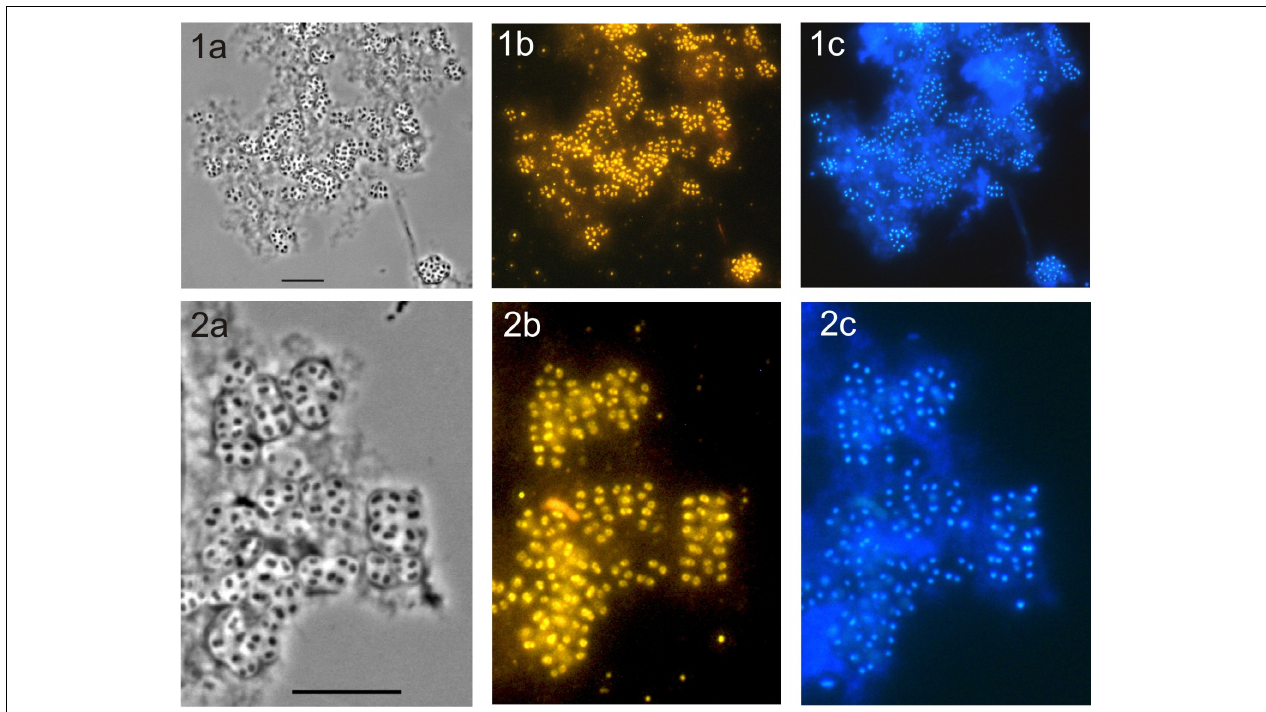
FIGURE 4 | Specific detection of cells of strain SBC82 T on micro-particles of amorphous chitin used in growth experiments as a sole source of carbon and nitrogen. The cultures were pictured after 20 days of incubation. Phase-contrast images (a) , the respective epifluorescent micrographs of whole-cell hybridizations with Cy3-labeled probe HoAc1402 (b) , and DAPI-staining (c) are shown. Rows ( 1 ) and ( 2 ) demonstrate different fields of view. Enlarged images in row ( 2 ) demonstrate characteristic cellular aggregates of strain SBC82 T . Bars, 10 µ